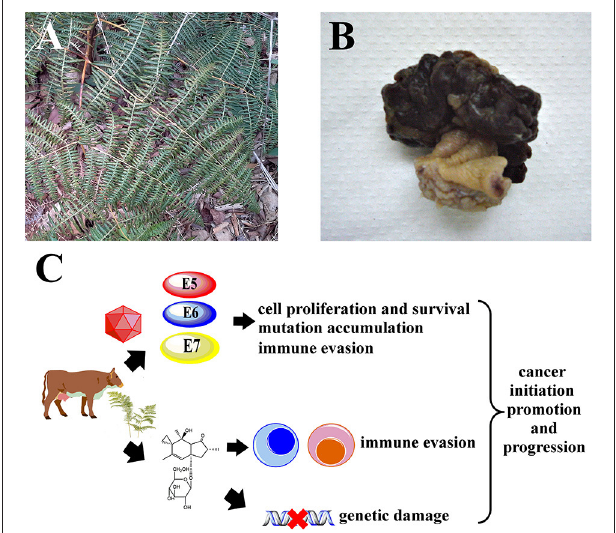
FIGURE 1 | It is hypothesized that Pteridium spp. and BPV synergize to drive carcinogenesis in cattle. (A) Mature Pteridium sp. fronds, Maranhão, Brazil. (B) Representative macroscopic view of a bovine urinary bladder hemangiossarcoma. (C) Illudane glycosides like ptaquiloside promote immune evasion by inactivating critical leukocytes like cytotoxic T lymphocytes and NK cells, allowing viral persistence. Genetic damage caused by bracken